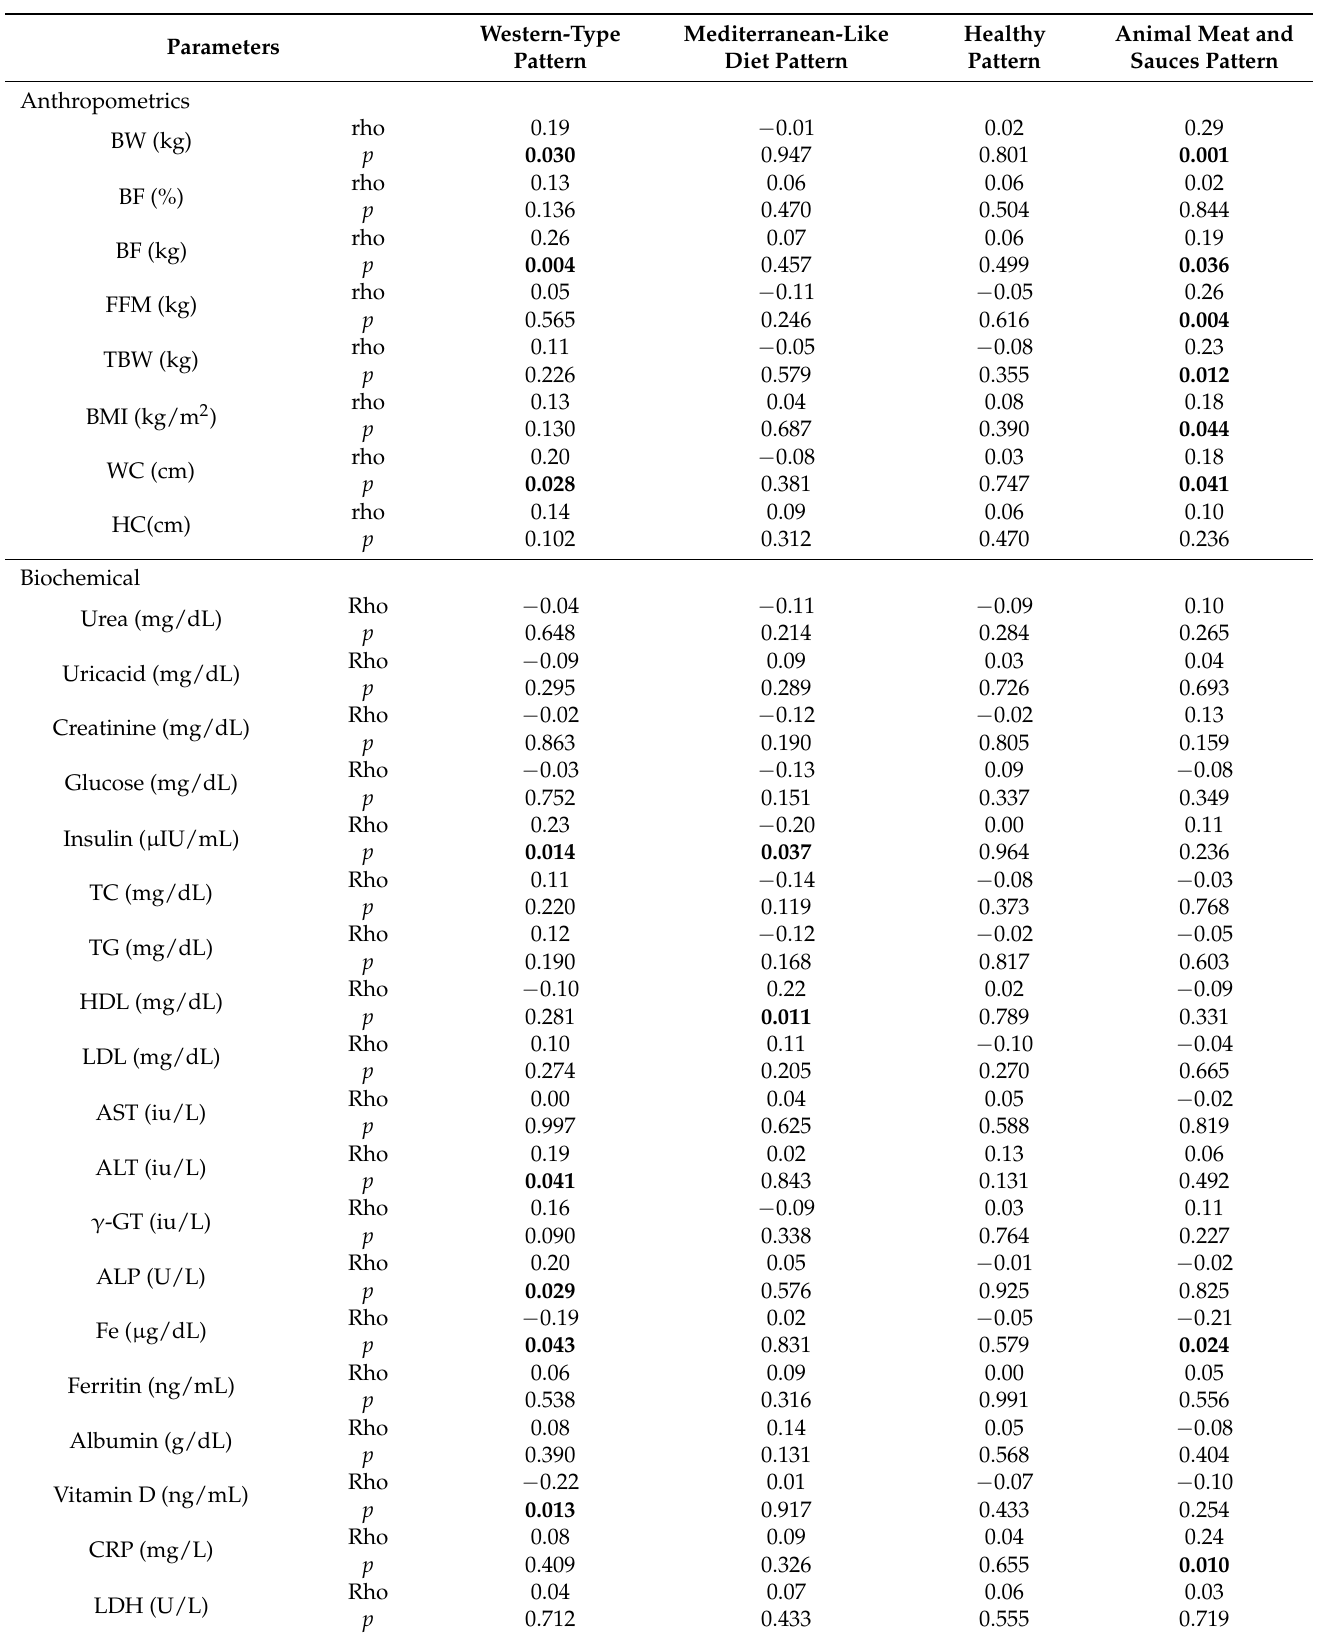
Table 3. Correlation between dietary patterns and anthropometrics, biochemical and lifestyle